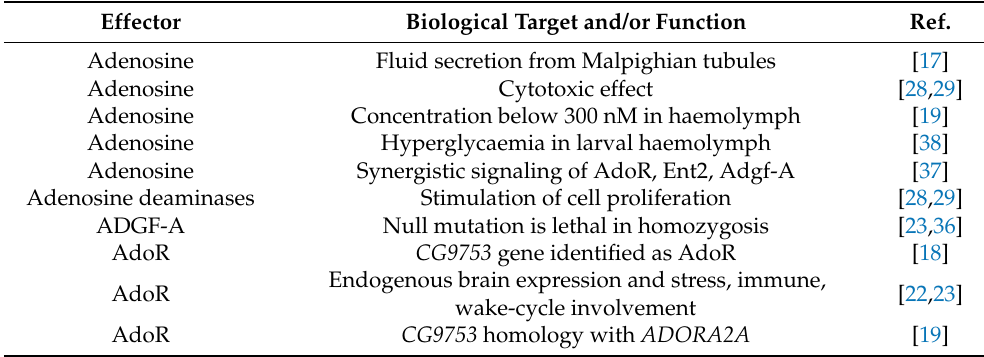
Table 1. Synoptic view of purinergic events in Drosophila melanogaster . The table summarizes the impact of purinergic actions and mechanisms described in Drosophila cells and